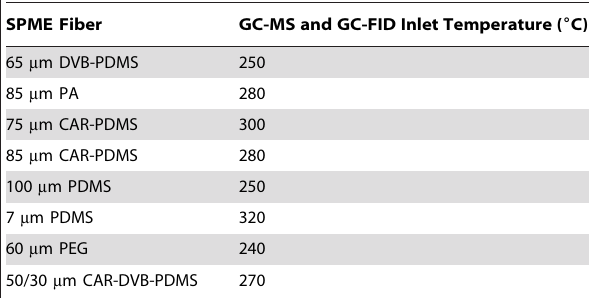
Table 1. GC Inlet temperatures per fiber type.